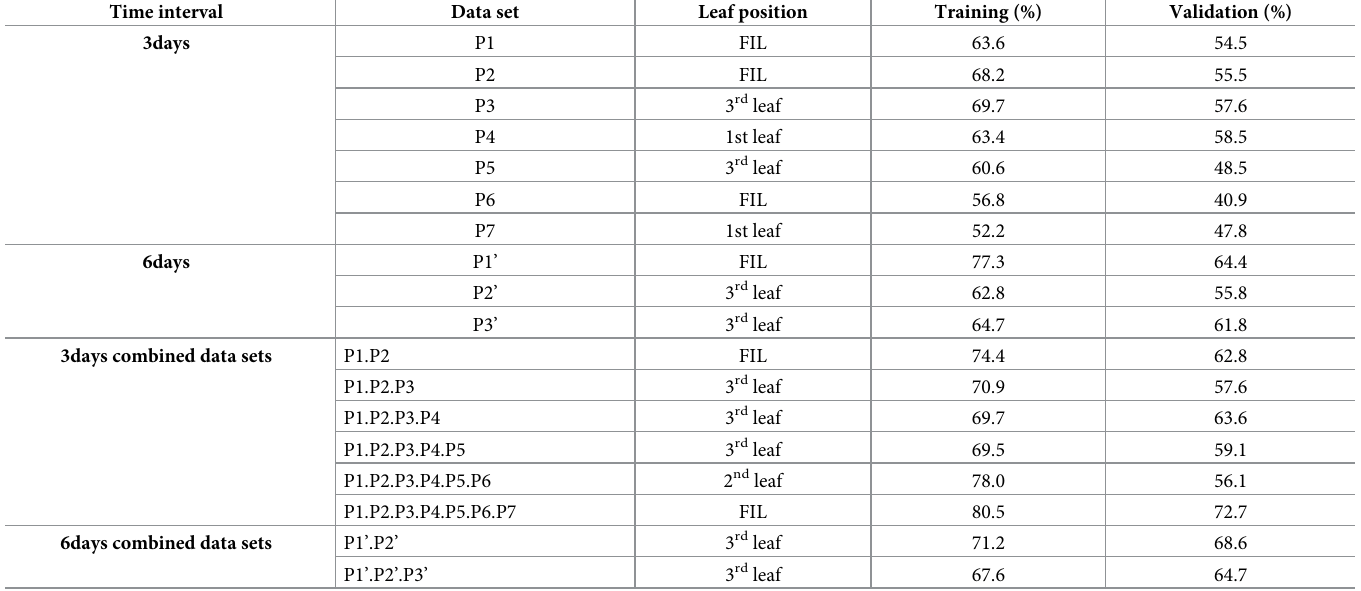
Table 5. Leaf position which got the best diagnostic accuracy in every data set. Time interval Data set